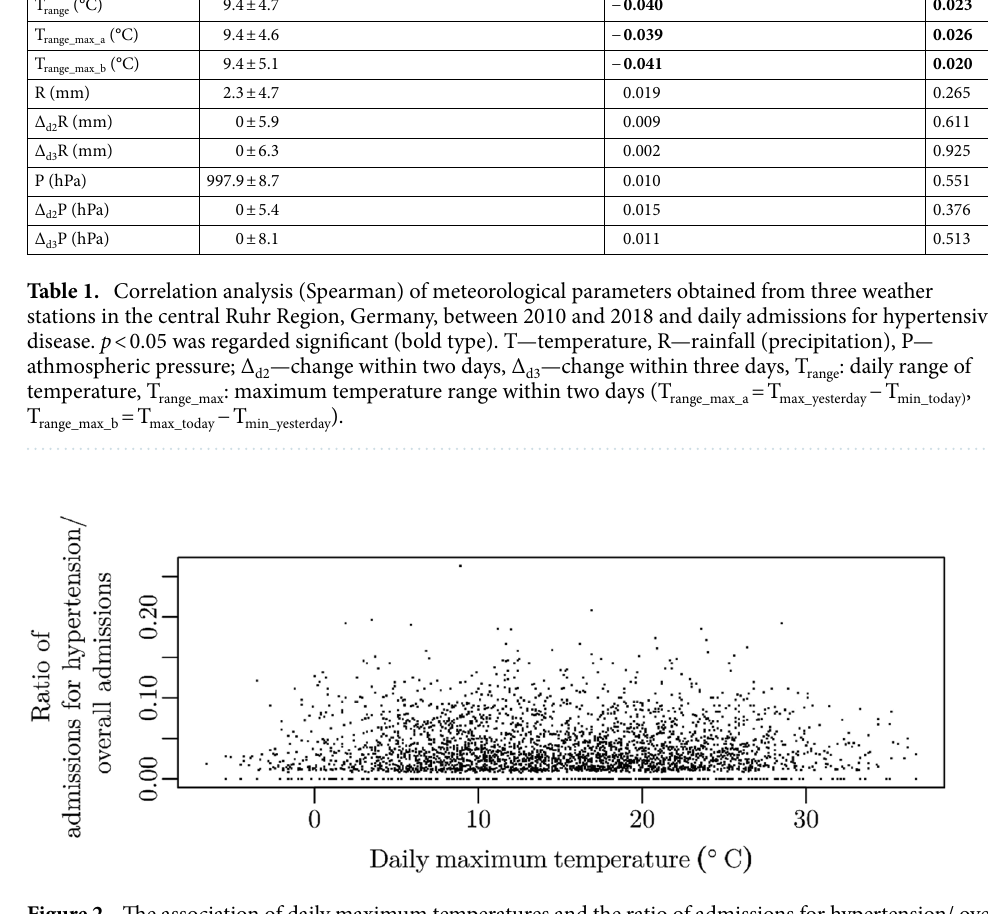
Figure 2. The association of daily maximum temperatures and the ratio of admissions for hypertension/ overall